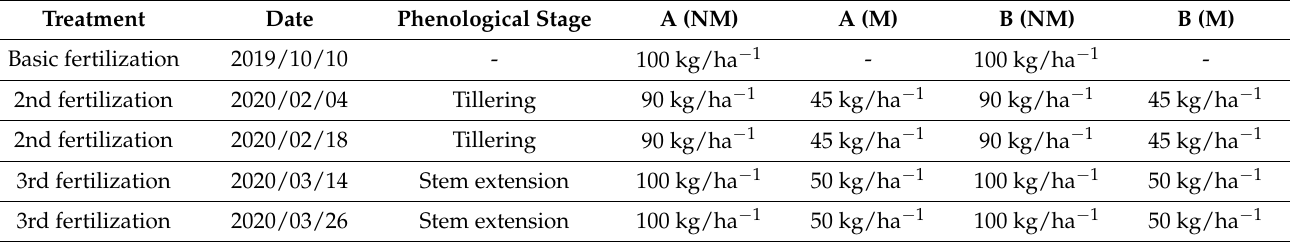
Table 5. Fertilization